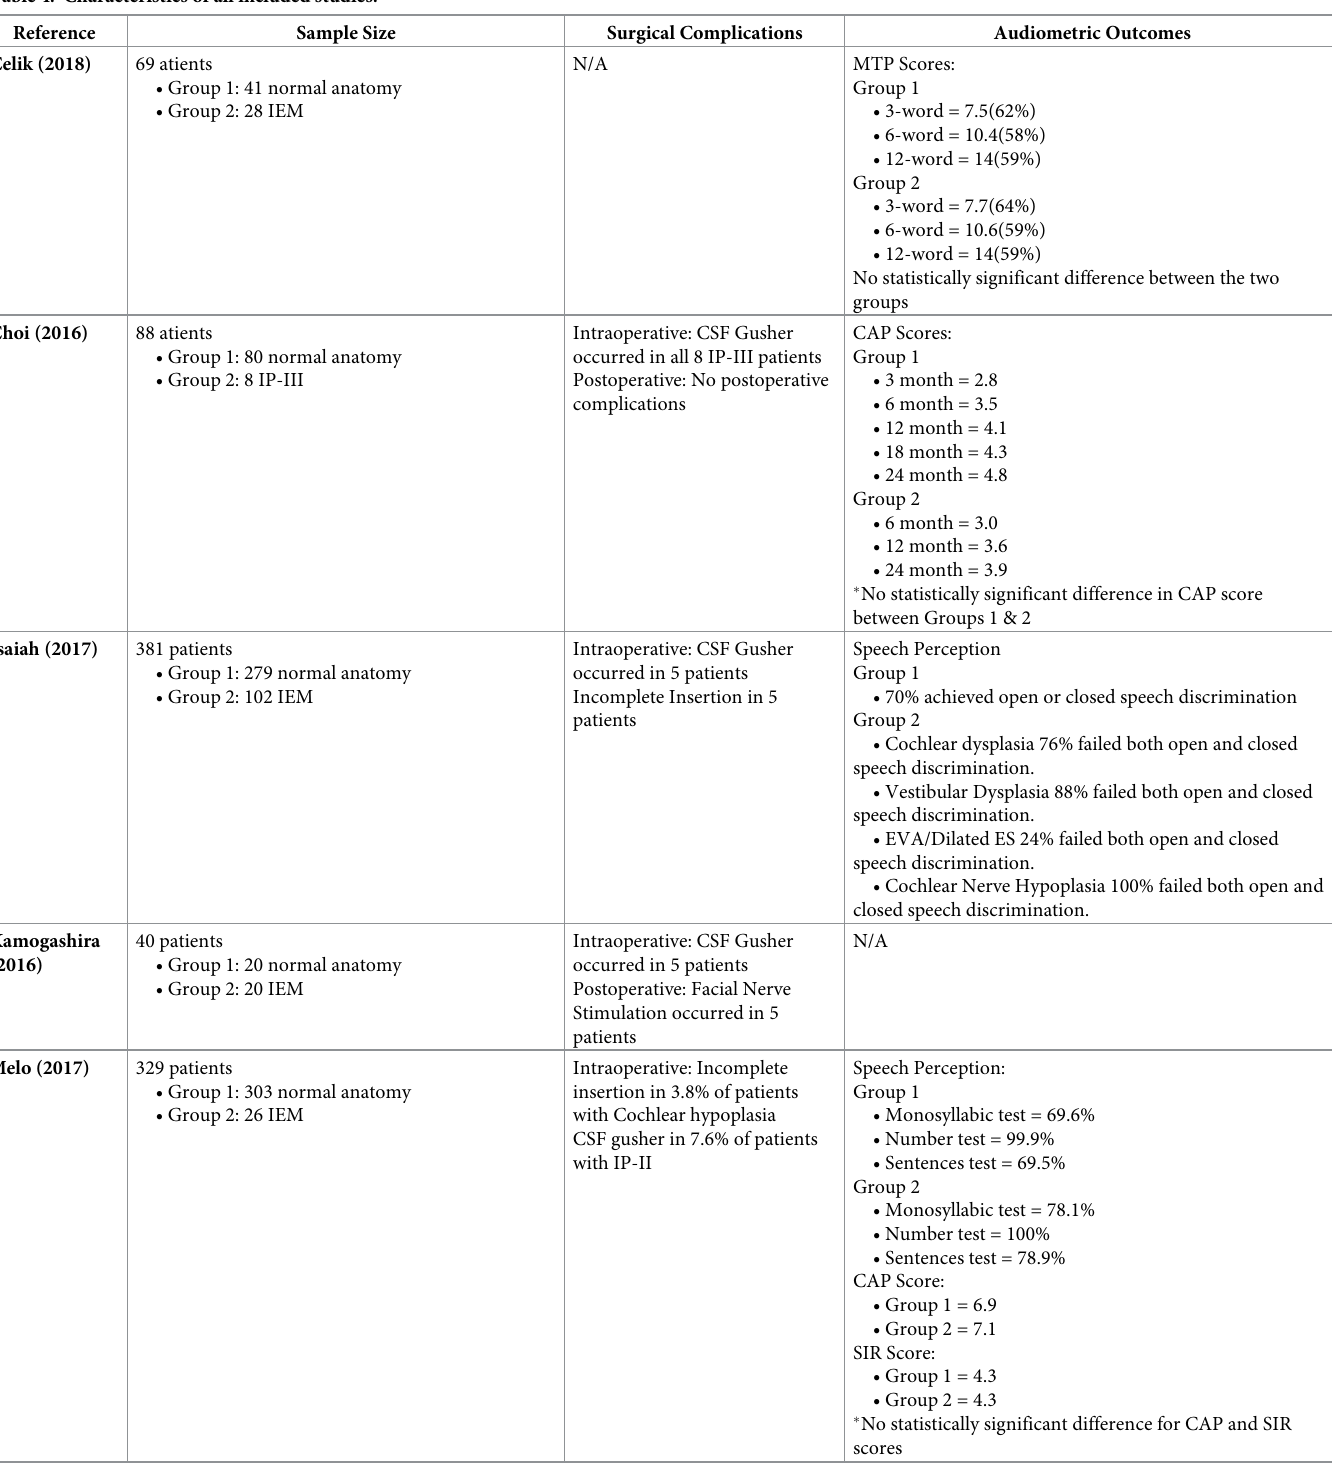
Table 4. Characteristics of all included